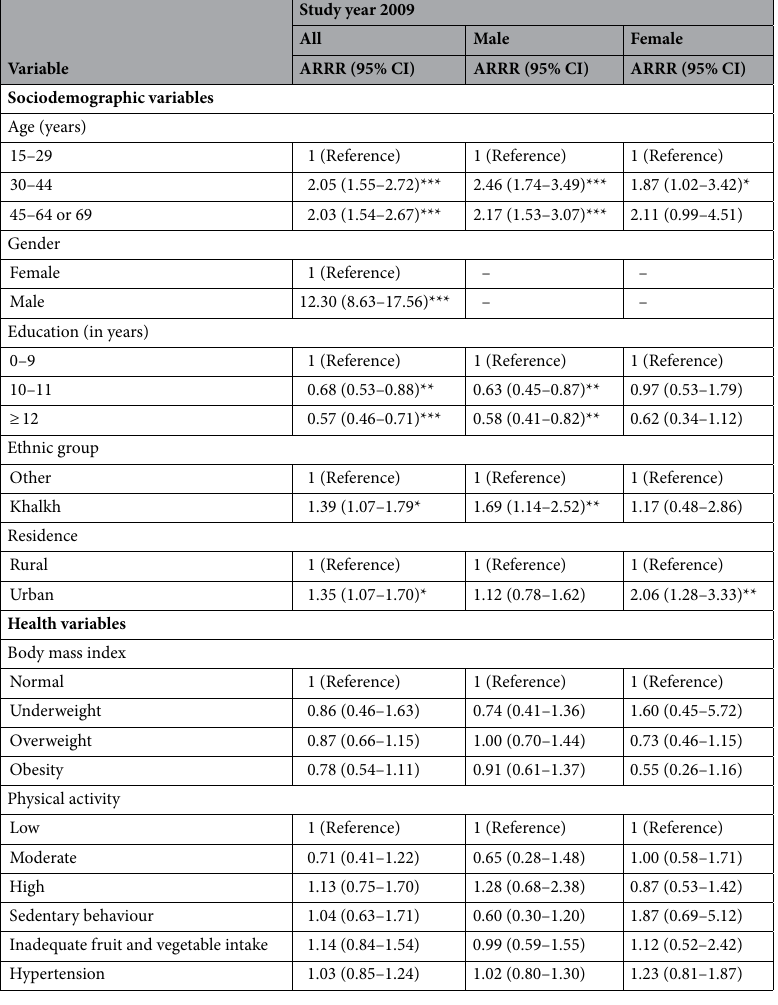
Table 8. Associations with current tobacco use only (with non-current tobacco and non-current heavy drinking as reference category) among 15 years and older individuals in Mongolia, 2009. *** p < 0.001; ** p < 0.01; * p < 0.05; ARRR Adjusted relative risk